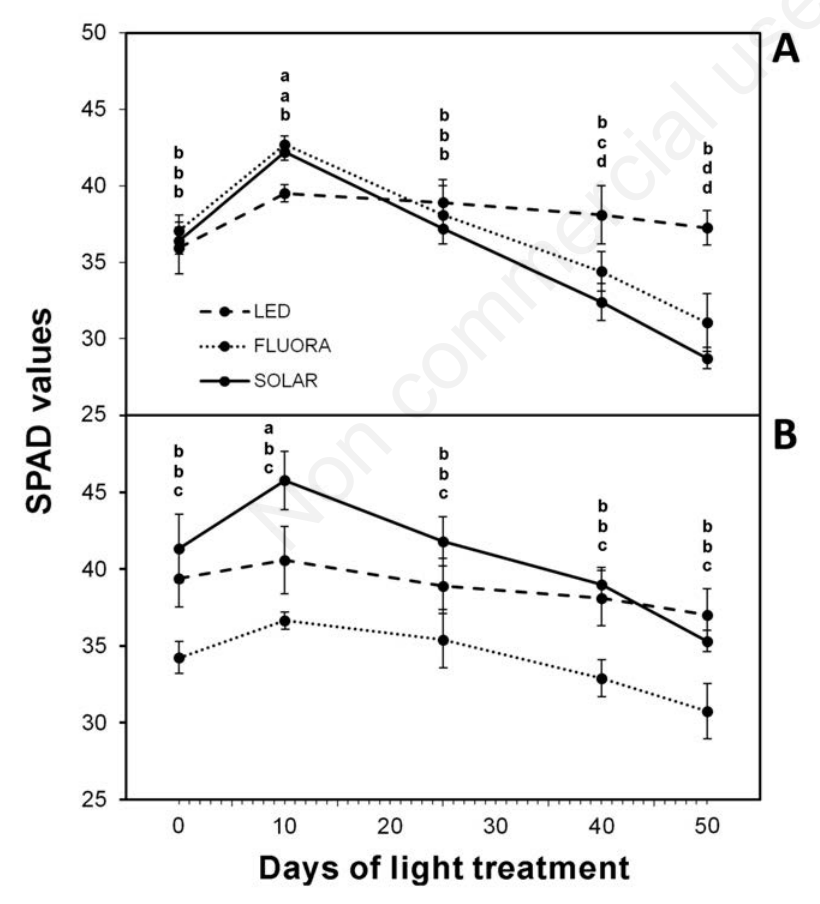
Figure 2. SPAD values in (A) common dandelion and (B) purple coneflower seedlings grown under light-emitting diodes (LED), FLUORA and solar light sources. Values are means of ten measurements on ten different plants (±SD) with ten independent replicates (n=10). Mean values with a different lower-case letter are significantly different among light treatments at P=0.05, according to Fisher’s Least Significant Difference